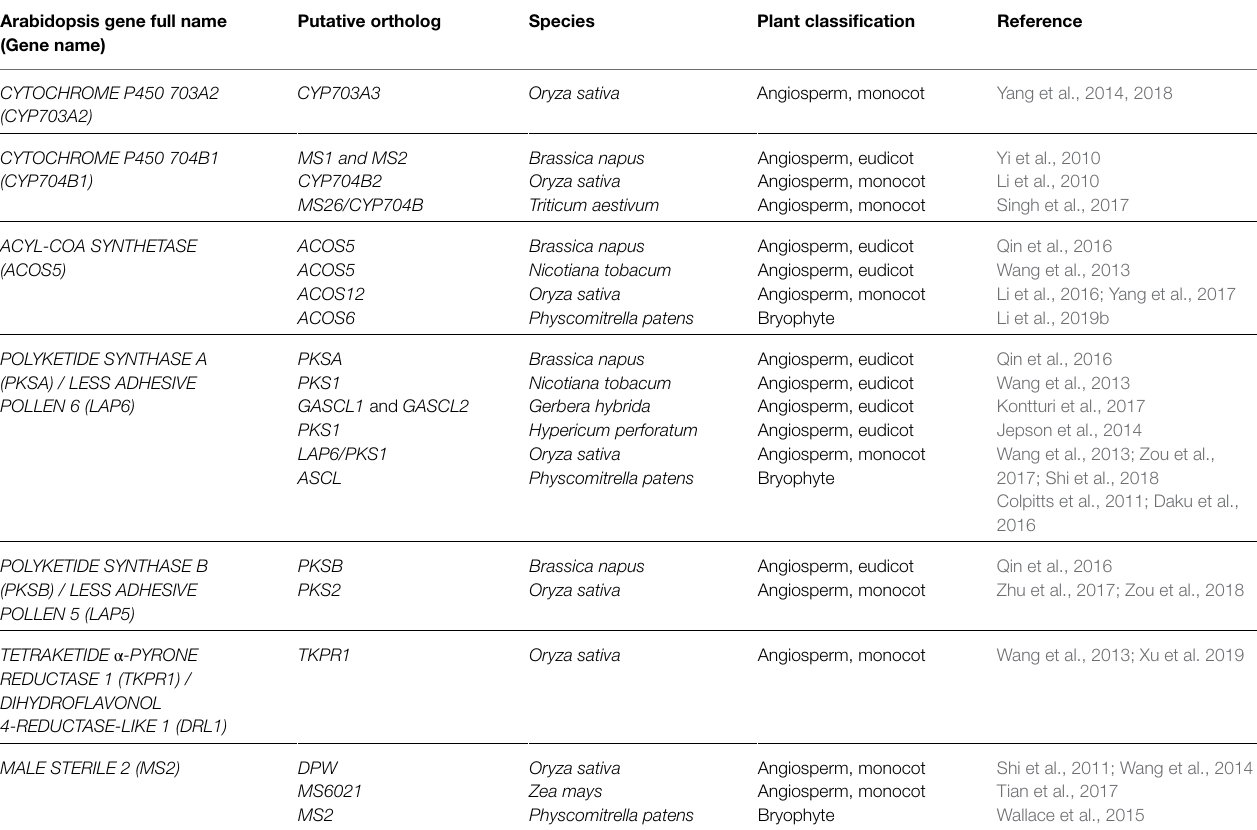
TABLE 1 | Summary of genes and putative orthologs encoding core enzymes required for sporopollenin biosynthesis. Arabidopsis gene full name (Gene